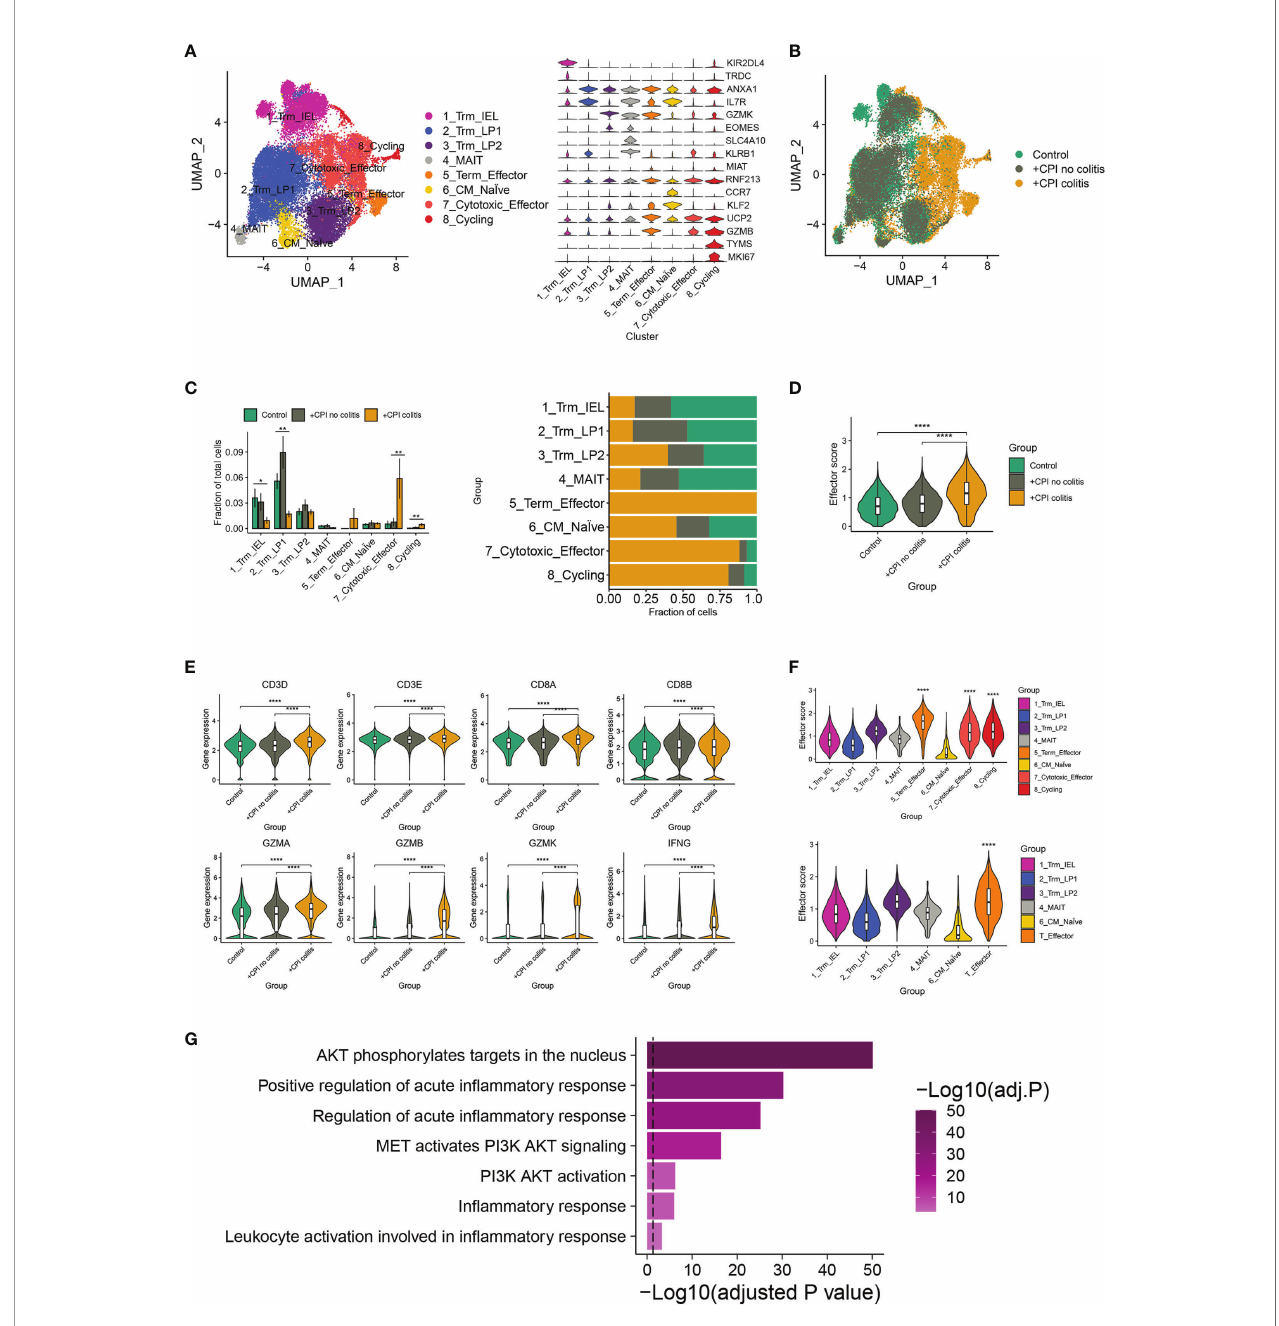
FIGURE 1 | irAEs-related changes in T cell sub-populations and mTOR pathways. (A) Identi fi cation of colon CD8 + T cell clusters across all samples (left). Violin plots (right) showing the expression levels of cluster-speci fi c marker genes in CD8+ T cells. Rows represent genes, and columns represent clusters. Each violin indicates the gene expression distribution within this cluster. (B) Distribution of CD8 + T cells across clusters among patient groups. (n=6-8 patients per group). (C) Quanti fi cation of cell cluster frequency representation (left) and distribution of cell clusters (right) among patient groups. * p < 0.05; ** p < 0.01, analyzed by two-sided Wilcoxon test comparing control and colitis groups, average and SEM are shown for each patient group. (D) Effector score of CD8 + T cells among patient groups. **** p < 0.0001, two-sided Wilcoxon test. (E) Violin plots showing the expression of selected effector marker genes among patient groups. **** p < 0.0001, two-sided Wilcoxon test. (F) Effector scores computed for each CD8 + T cell sub-cluster (top) and effector T cell cluster (down). **** p < 0.0001, two-sided Wilcoxon test. (G) Gene set enrichment analysis of effector T cells and other CD8 + T cells. Method used to adjust the p-values is